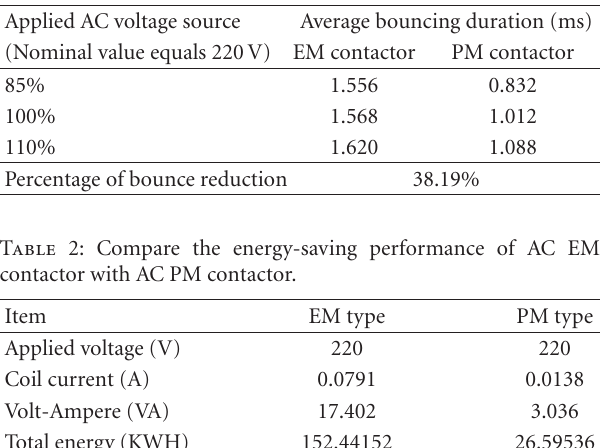
Table 1: Comparisons of average bouncing duration of a pair of contacts after collision for both AC PM contactor and AC EM contactor.